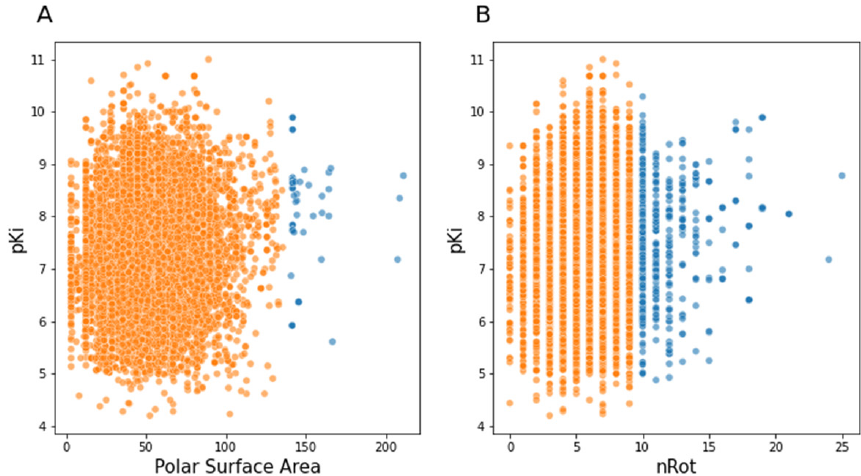
Figure 6. Scatterplots of pKi value and advanced properties of the rule of five: ( A ) polar surface area; ( B ) number of rotatable bonds (nRot).